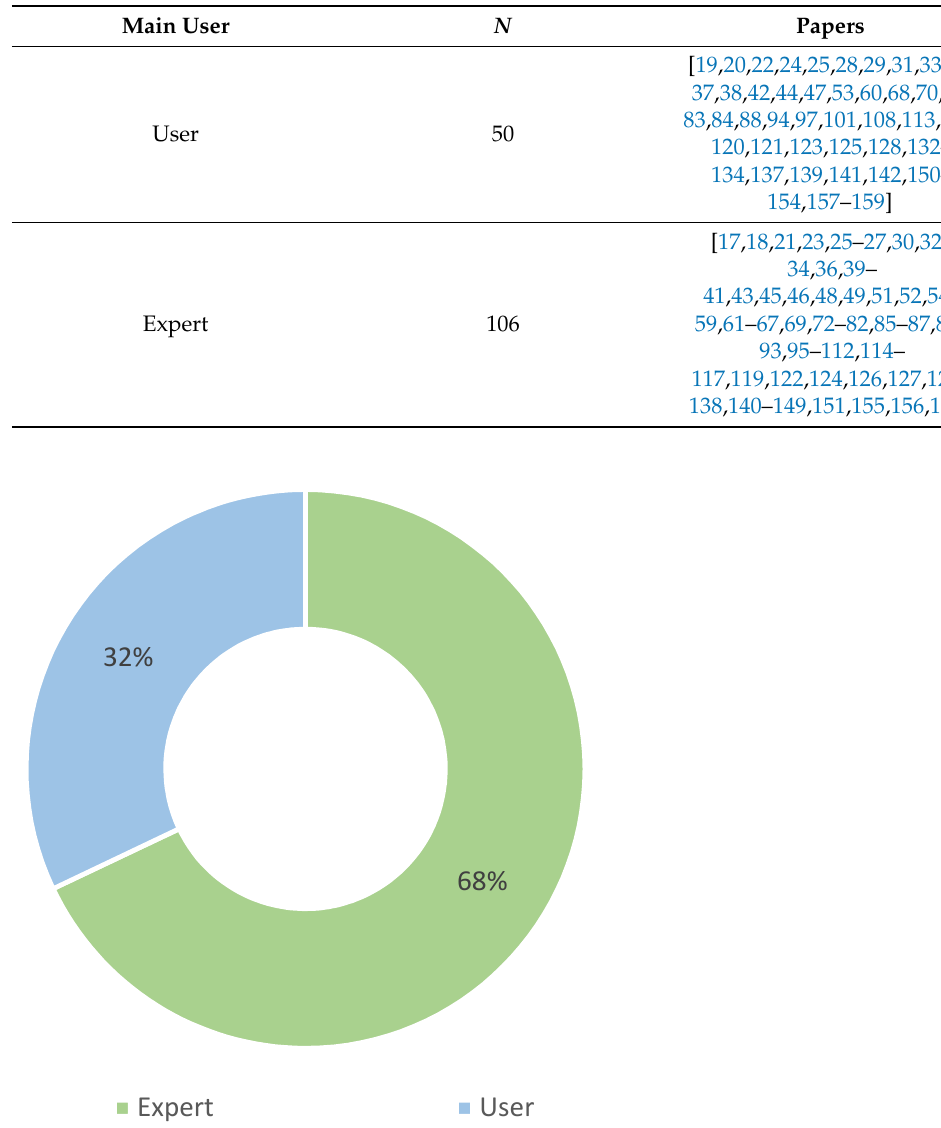
Table 9. Primary users of BMF system.